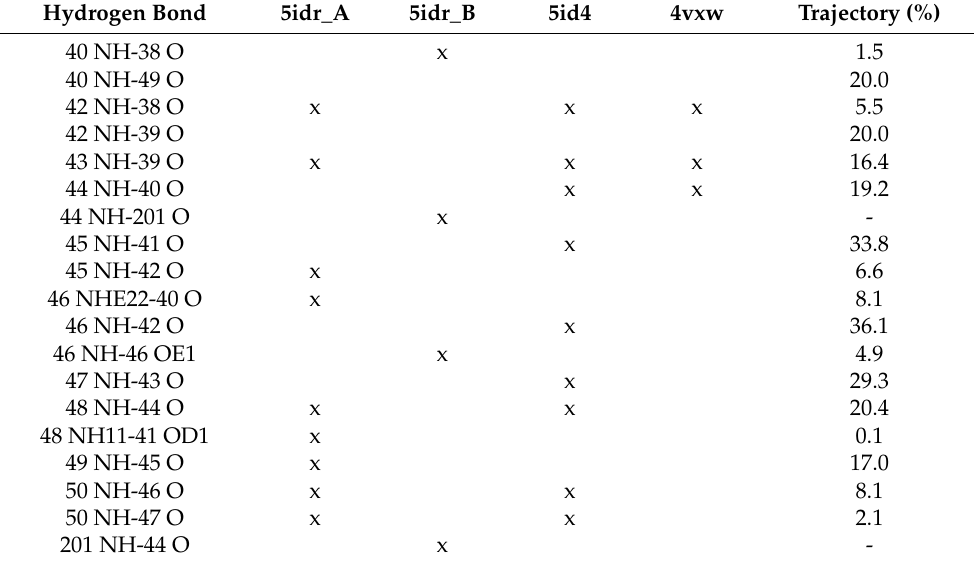
Figure 3. The four central structures show the loop (4xvw, molecule A), helix (5id4), β -strand (5idr molecule B) and irregular helix (5idr molecule A) conformations of the linker peptide in crystal structures which were used as starting structures for the MD simulations. The secondary structure indicated is that present in the intact protein trimer. Structures 1–7 show the conformations at the centres of the seven main clusters identified in the combined four 100 ns MD simulations of the linker peptides. The arrows indicate the main trajectories whose conformers contribute to the cluster. Two or more adjacent residues with Φ , Ψ torsion angles in the α or β region of the Ramachandran plot are shown in red and green, respectively. In each case the peptide is orientated with the N-terminus to the left. Table 1. Hydrogen bonds in the linker peptide in the X-ray structures used as starting coordinate sets for the MD simulations and their percentage populations in the combined trajectory of the four 100 ns peptide MD simulations. Only hydrogen bonds in the X-ray structures, or with a population of at least 20% in the simulations, are included. Note that residue 201 is in the catalytic domain, in the region that forms the β -sheet with the linker peptide in the transitional X-ray